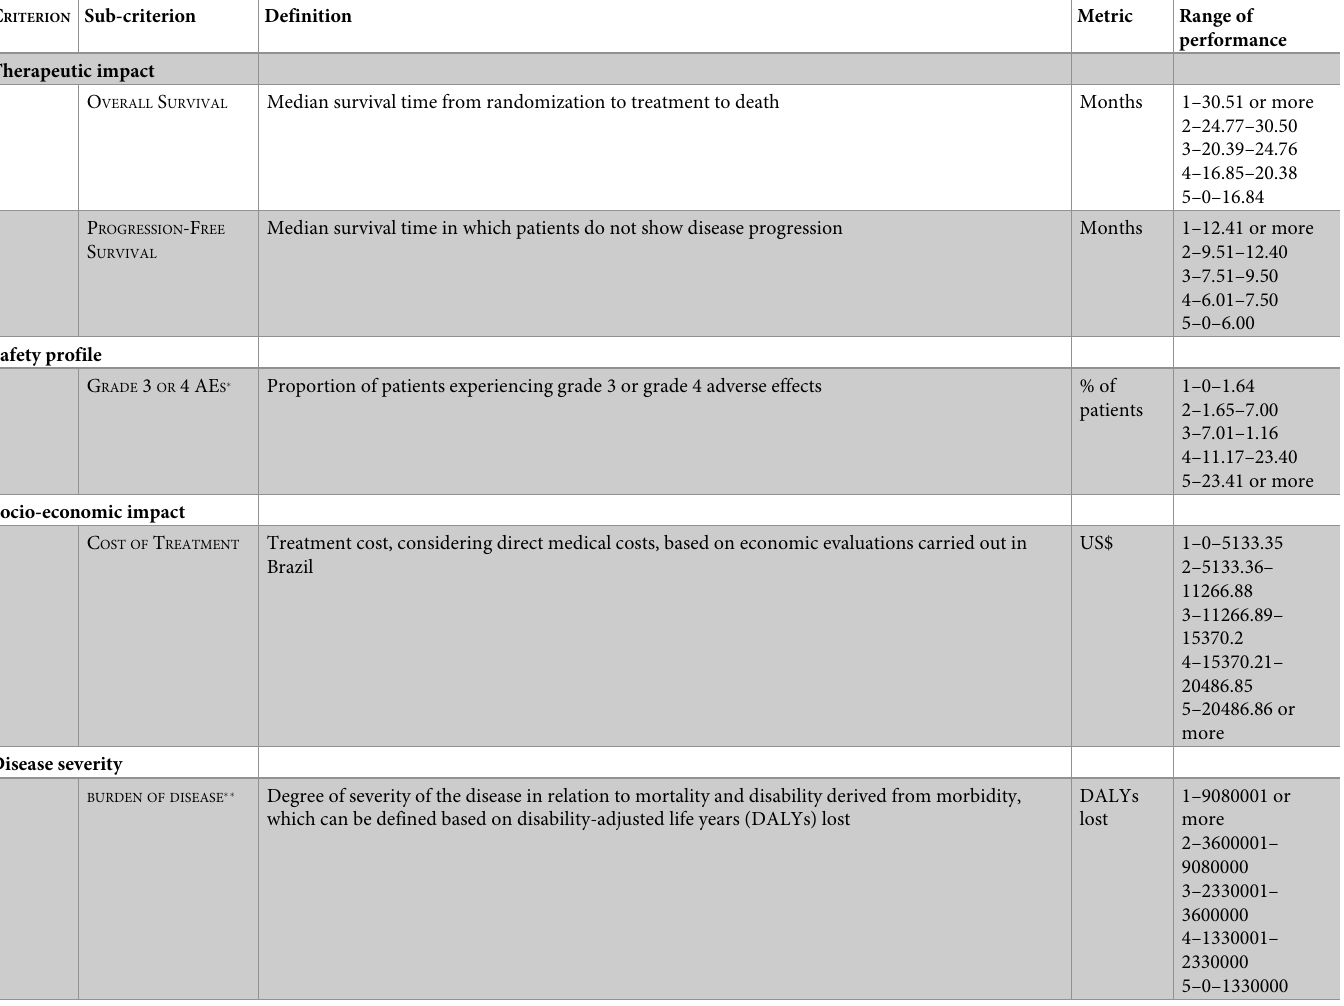
Table 1. Criteria definitions and range of